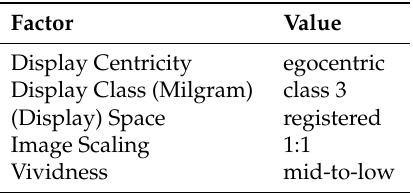
Table 4. Image/display/vision.